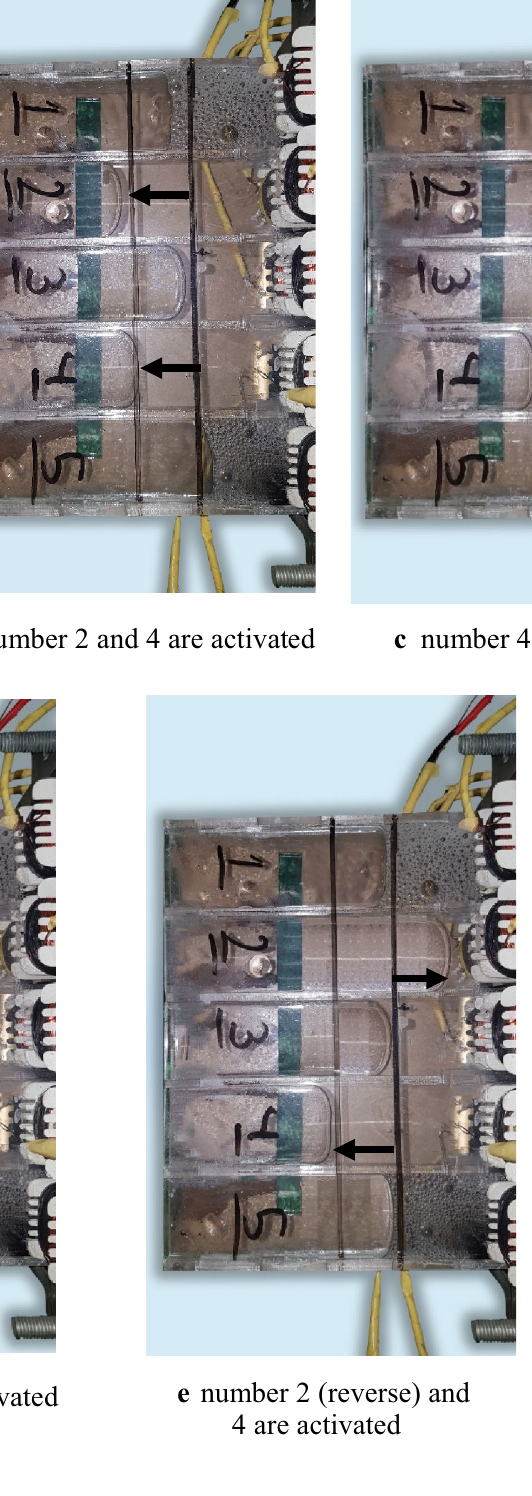
Fig. 19 The experimental test